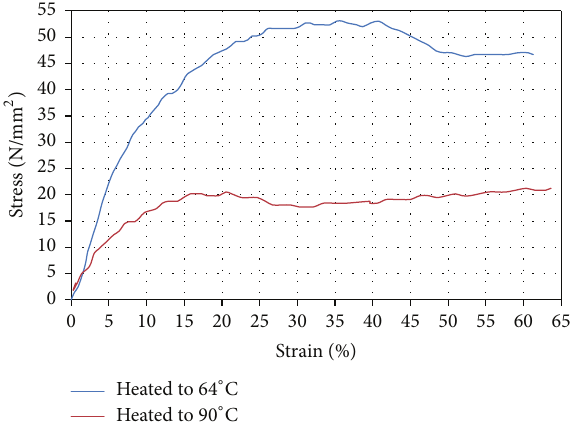
Figure 7: Stress-strain diagram for heated